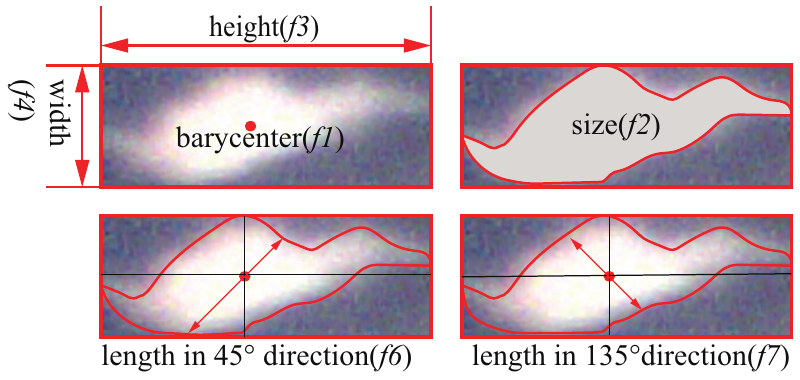
Figure 7. Illustration of each